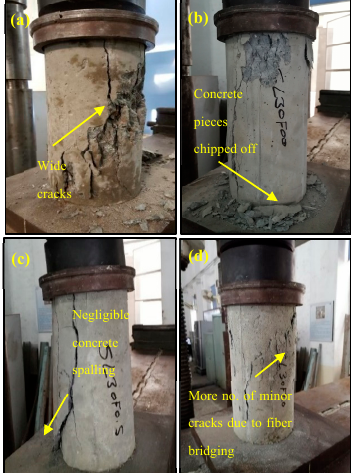
Figure 5. Observed failures in compression test of ( a ) control concrete, ( b ) slag + 0.0% PP fibers group, ( c ) slag + 0.5% PP fibers group, ( d ) slag + 1.0% PP fibers group.